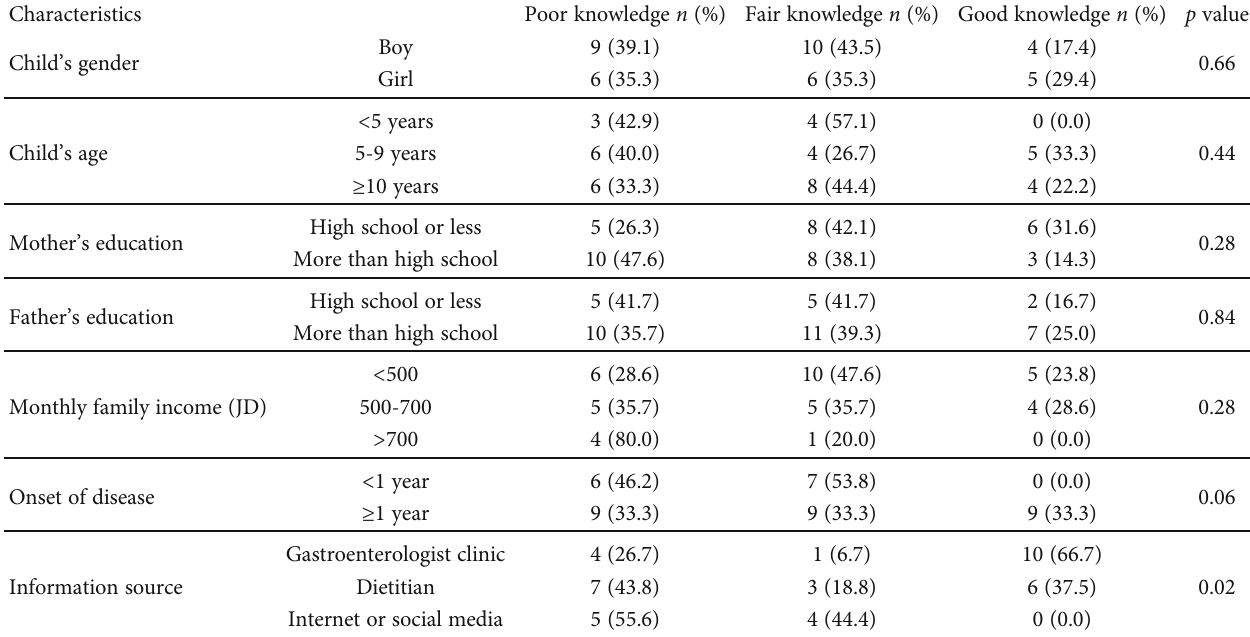
Table 2: Relationship between nutrition knowledge categories among CD parents and the sociodemographic characteristics of CD patients and their parents.